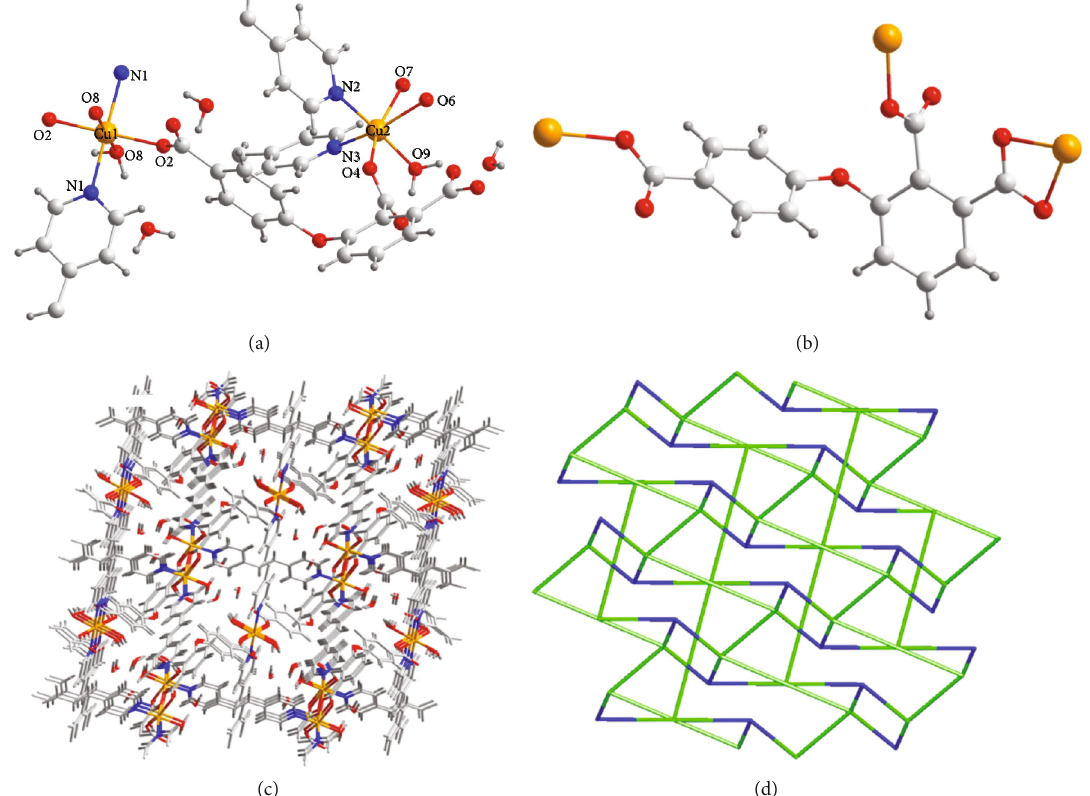
Figure 2: (a) The coordination manner for the Cu ions. (b) The coordination mode for the ligand. (c) The 2 ’ s 3-dimensional net. (d) The 3,4,4-linked net of compound 2.